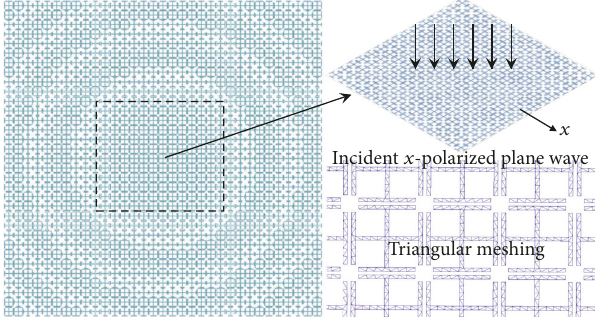
Figure 10: Geometry of flat lens on substrate and its meshing